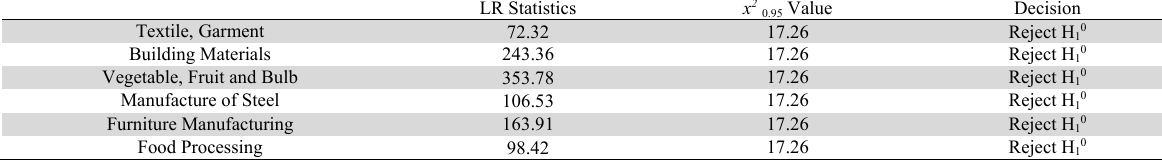
Generalized Likelihood Ratio Test for Functional Form Null Hypothesis: H 10 : β 4= β 5= β 6= β 7= β 8= β 9 = 0 (Production function is